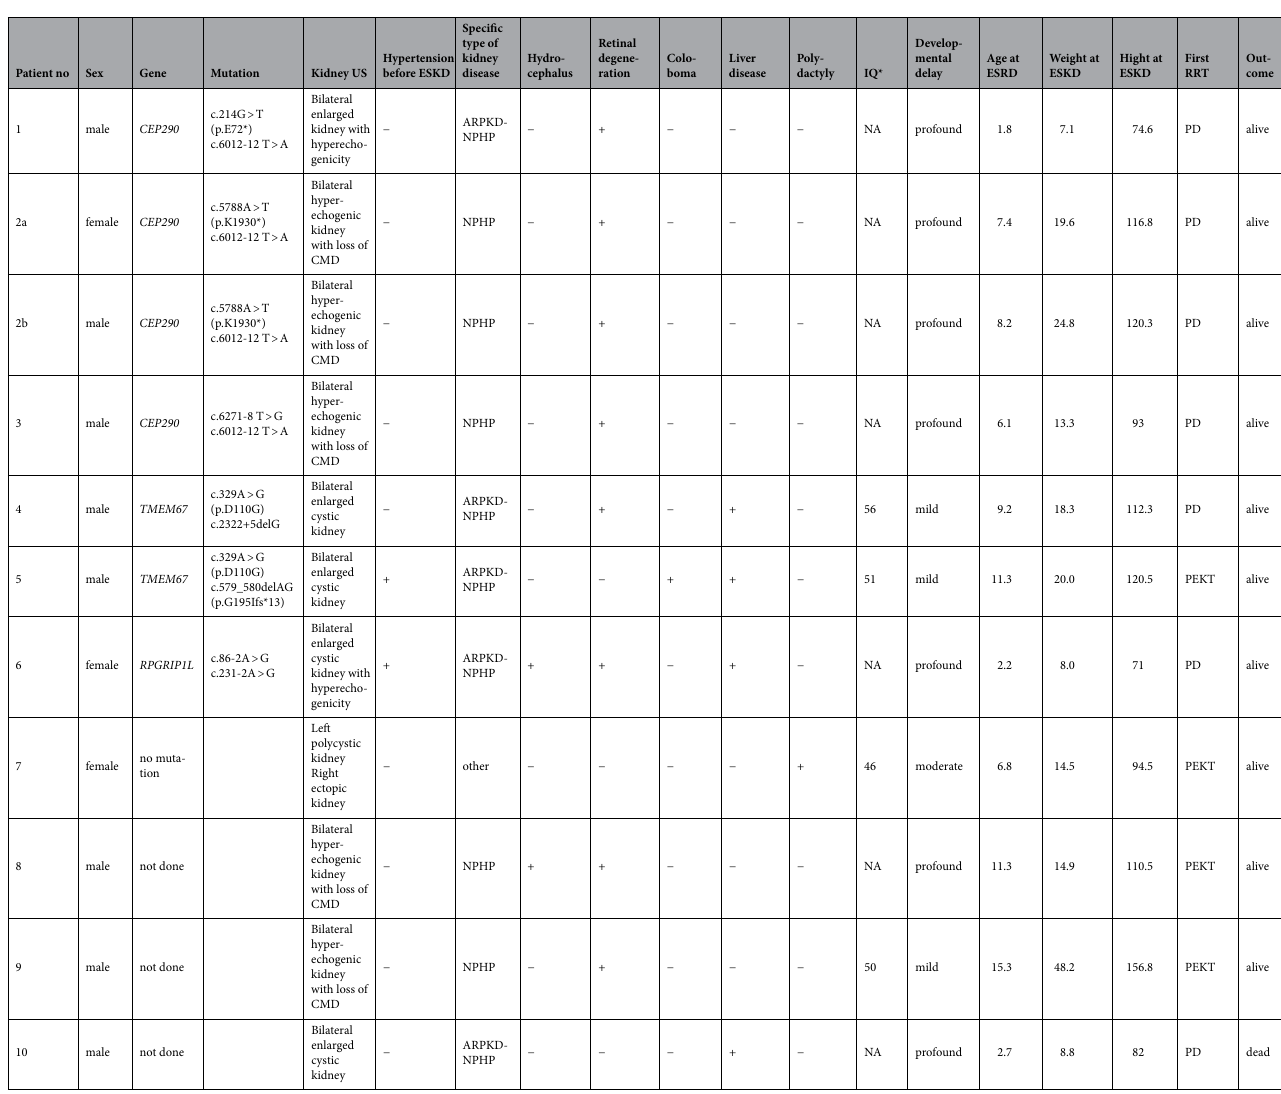
Table 1. Clinical characteristics of the patients. *Patients in which Wechsler Intelligence Scale for Children testing was not possible due to severe developmental delay (designated as NA) were considered to have profound developmental delay. RRT renal replacement therapy, CMD corticomedullary differentiation, ARPKD autosomal recessive polycystic kidney disease, NPHP nephronophthisis, PKD polycystic kidney disease, NA not applicable, PD peritoneal dialysis, PEKT preemptive kidney transplantation; 2a and 2b are